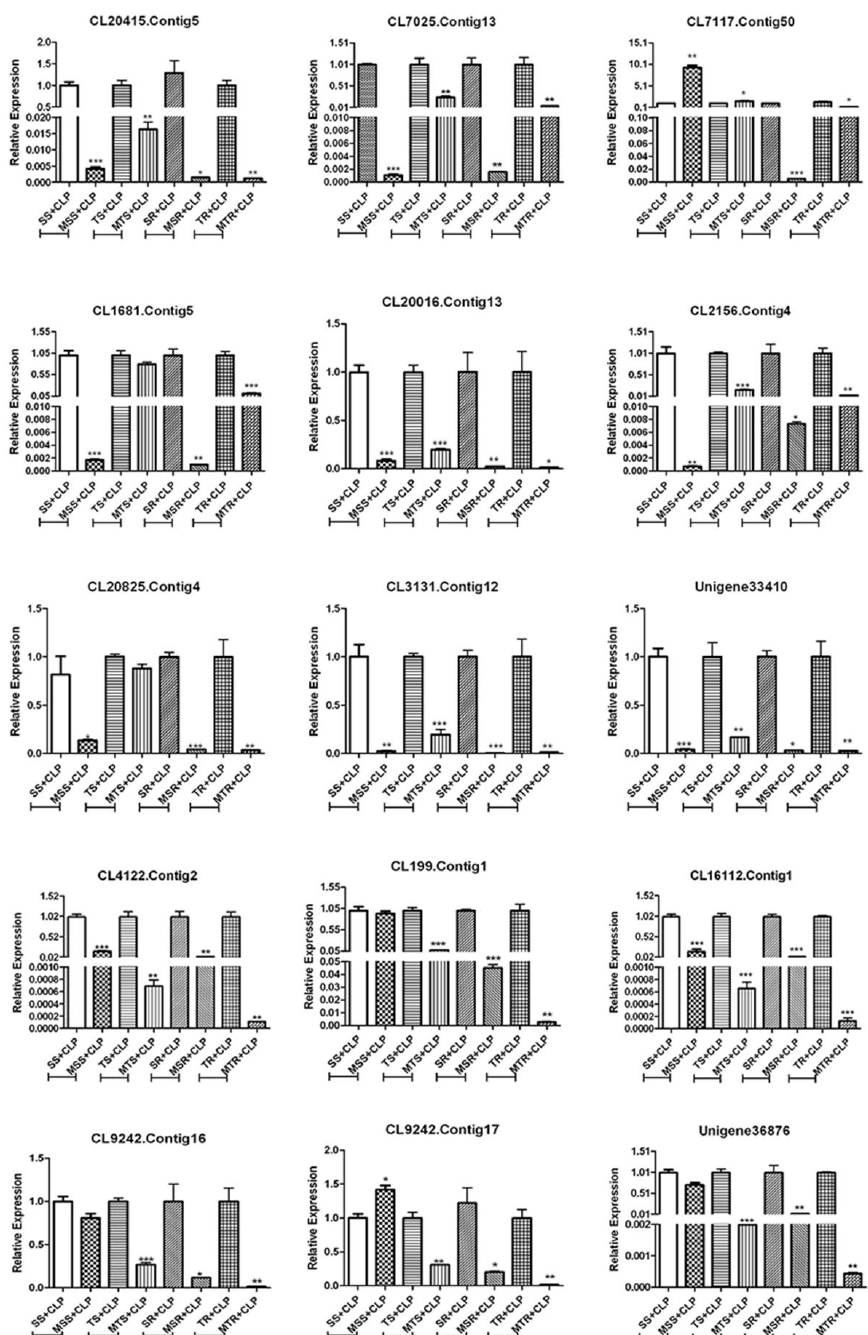
Figure 5. qRT-PCR validation of candidate NTSR gene expression in Intra-group (application herbi- cide in the same population) with or without pre-application of malathion. Three replicates were performed for each of the three biological replicates. The error bars represent the standard error of the mean. SS: susceptible population in the seedling stage; SR: resistant population in the seedling stage; TS: susceptible population in the tillering stage; TR: resistant population in the tillering stage; MSS: prior application of malathion in the susceptible population in the seedling stage; MSR: prior application of malathion in the resistant population in the seedling stage; MTS: prior application of malathion in the susceptible population in the tillering stage; MTR: prior application of malathion in the resistant population in the tillering stage; +CLP: application of clodinafop-propargyl. * p < 0.05, ** p < 0.01, *** p <